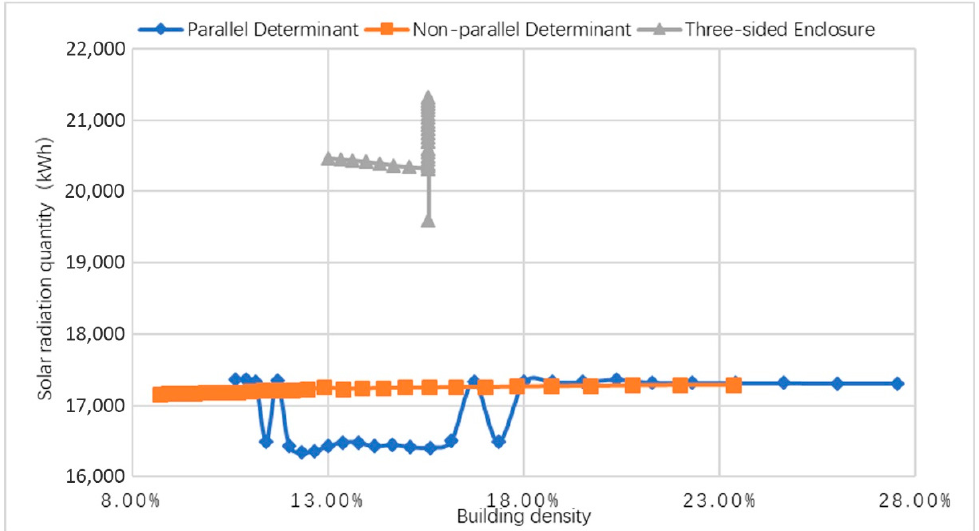
Figure 8. Relationship between building density and solar radiation quantity.